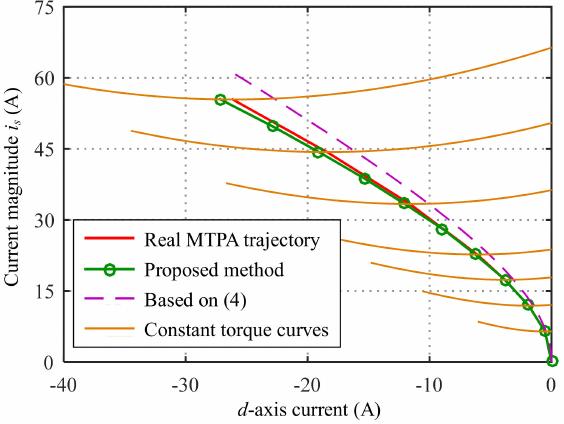
Figure 9. Experimental current trajectory of the proposed method and other comparable current